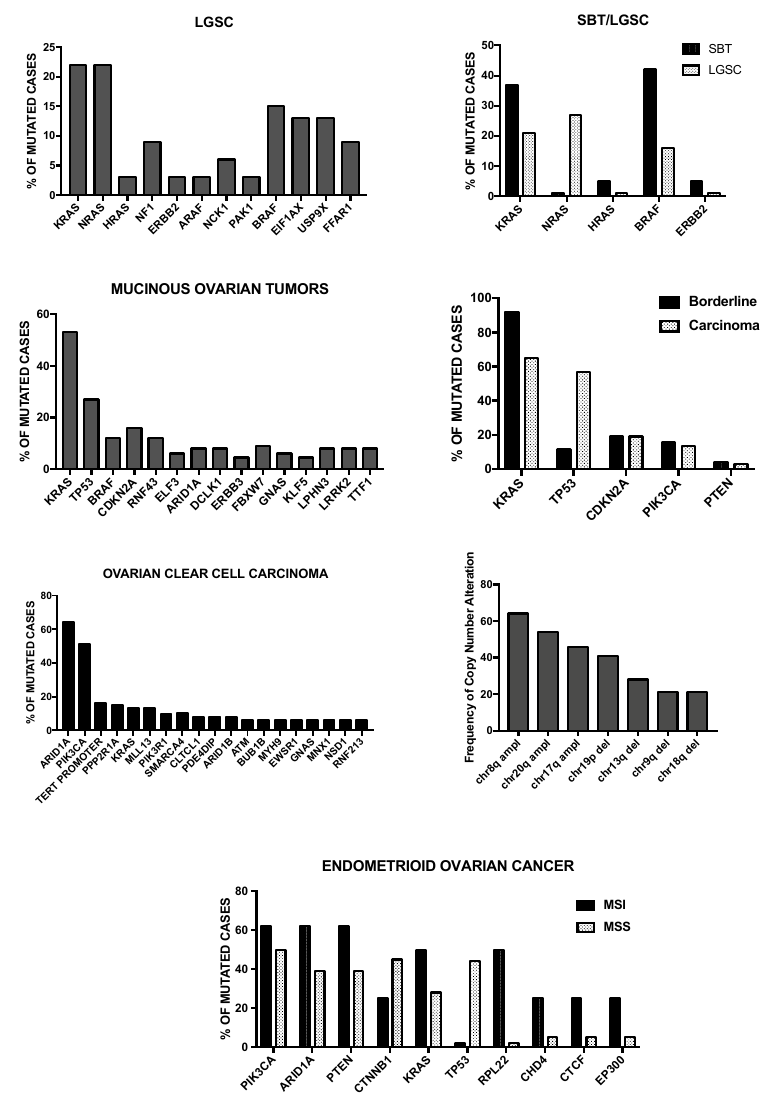
Figure 2. ( Top Panel, left ): Mutational spectrum observed in LGSOC patients; ( Top Panel, right ): comparative analysis of the frequency of the main mutations observed through paired comparison odf serous borderline tumors (SBT) and LGSOCs. The data reported in these two figures are from ref. [103]; ( Middle Panel, Top, left ): Recurrent mutations observed in mucinous cancers of the ovary; ( Middle Panel, Top, right ): comparative analysis of some recurrently mutated genes at the level of borderline precursor lesions and mucinous carcinomas; ( Middle Panel, Bottom, left ): Recurrent mutations observed in ovarian clear-cell carcinoma; ( Middle Panel, Bottom, right ): Recurrent copy number alterations observed in ovarian clear-cell carcinoma. The data shown in these two figures are reported in the references [117,118]; ( Bottom Panel ): Recurrent gene mutations observed in endometrioid ovarian cancers subdivided into microsatellite instable (MSI) and microsatellite stable (MSS) subgroups. The data shown in this figure are reported from ref. [27].